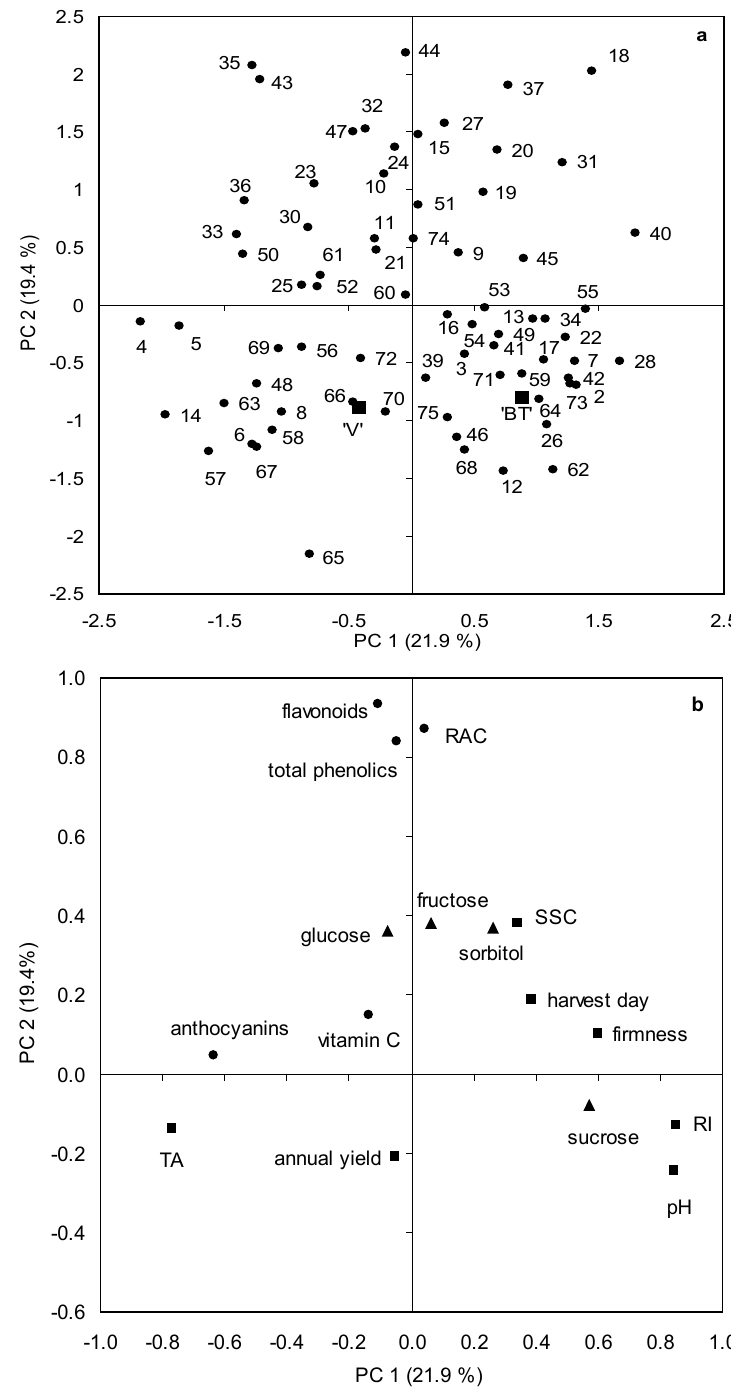
Figure 3. Principal component analysis of agronomical and biochemical traits in the “Venus” × “Big Top” progeny. Analysis was performed using mean data of four years of study (2007–2010). PC1/PC2 scores plot ( a ) explaining 41.3% of the total variance. Symbols: ( ■) parents “Venus” ( ‘V’) and “Big Top” (‘BT’), ( ●) progeny. PC1/PC2 loadings plot ( b ) generated from PCA analysis. Symbols: ( ■) agronomical and basic biochemical traits, ( ●) antioxidants, ( ▲)